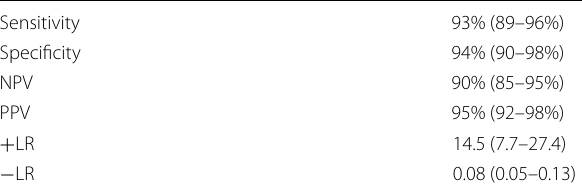
Table 2 EUS ability to detect gallstones